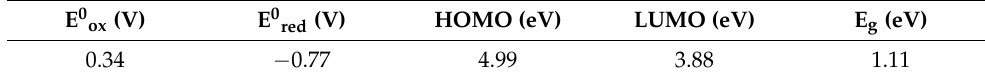
Table 5. Electrochemical data determined from the peak potential